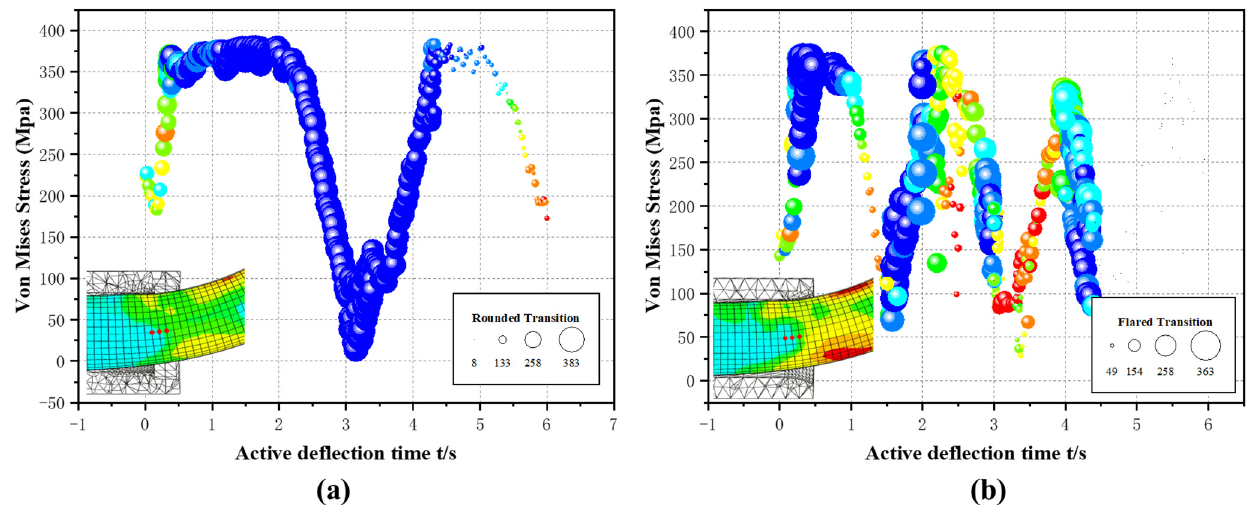
Figure 13. The Von Mises stress distribution of the tubes based on different transition structures: ( a ) rounded transition; ( b ) bell-shaped transition.